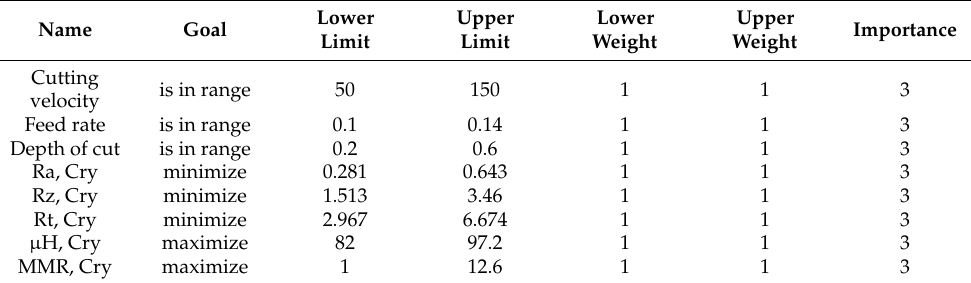
Table 9. Optimization objectives and parameters, and their respective limits.